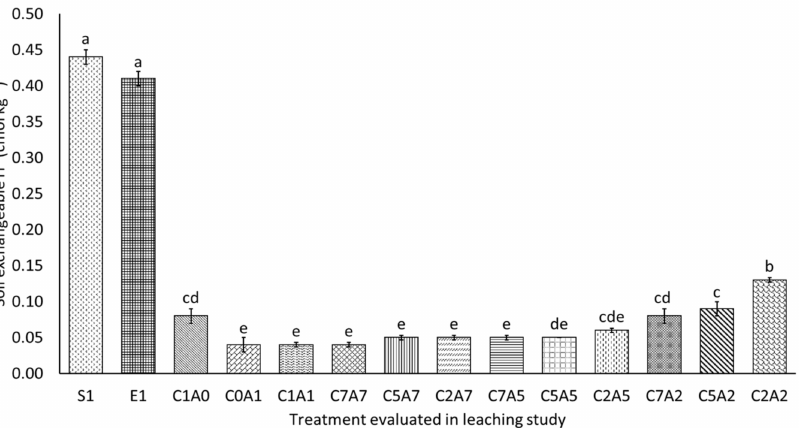
Figure 9. Treatments on soil exchangeable hydrogen after thirty days of leaching, where S1: soil only; E1: soil with ERP only; C1: 100% charcoal; C0: 0% charcoal; C7: 75% charcoal; C5: 50% charcoal; C2: 25% charcoal; A1: 100% sago bark ash; A0: 0% sago bark ash; A7: 75% sago bark ash; A5: 50% sago bark ash; A2: 25% sago bark ash. Means with different letter(s) indicate significant differences between treatments according to Tukey’s HSD test at p ≤ 0.05, that is, a > b > c. Bars represent the mean values ±